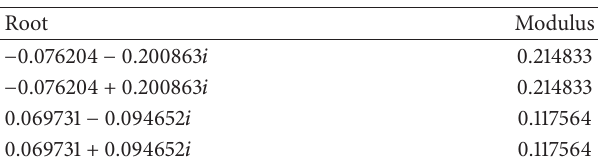
Table 1: The result of the unit root test.